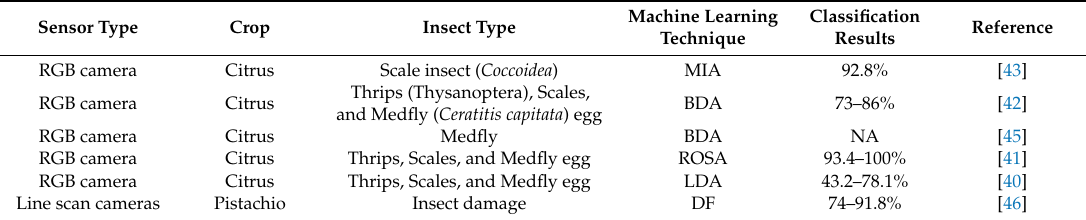
Table 1. Studies on detection of insect infestations in fruits and vegetables using visible color